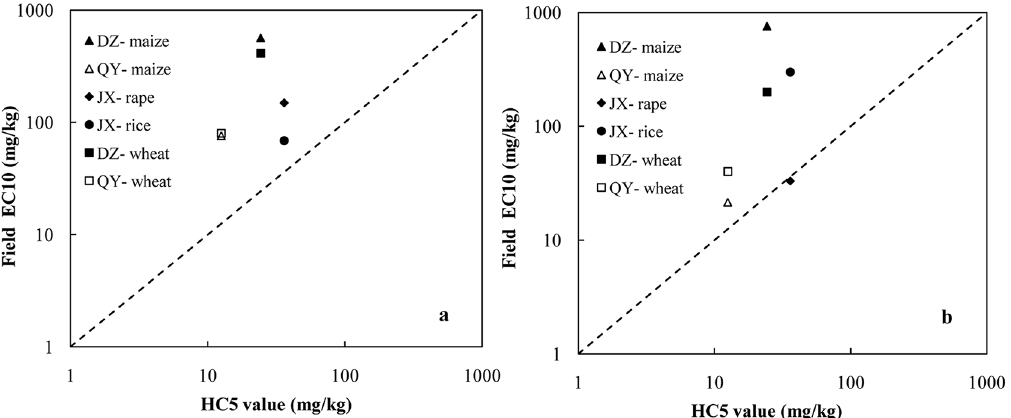
Fig 6. Comparison of HC5 derived using ecotoxicity data from different field crops at three field sites. The ecotoxicity data were obtained from field experiments conducted in three field sites from Qiyang in Hunan (QY) as acidic soil, Dezhou in Shandong (DZ) as alkaline soil, and Jiaxing in Zhejiang (JX) as neutral soil in 2007 (a) and 2008